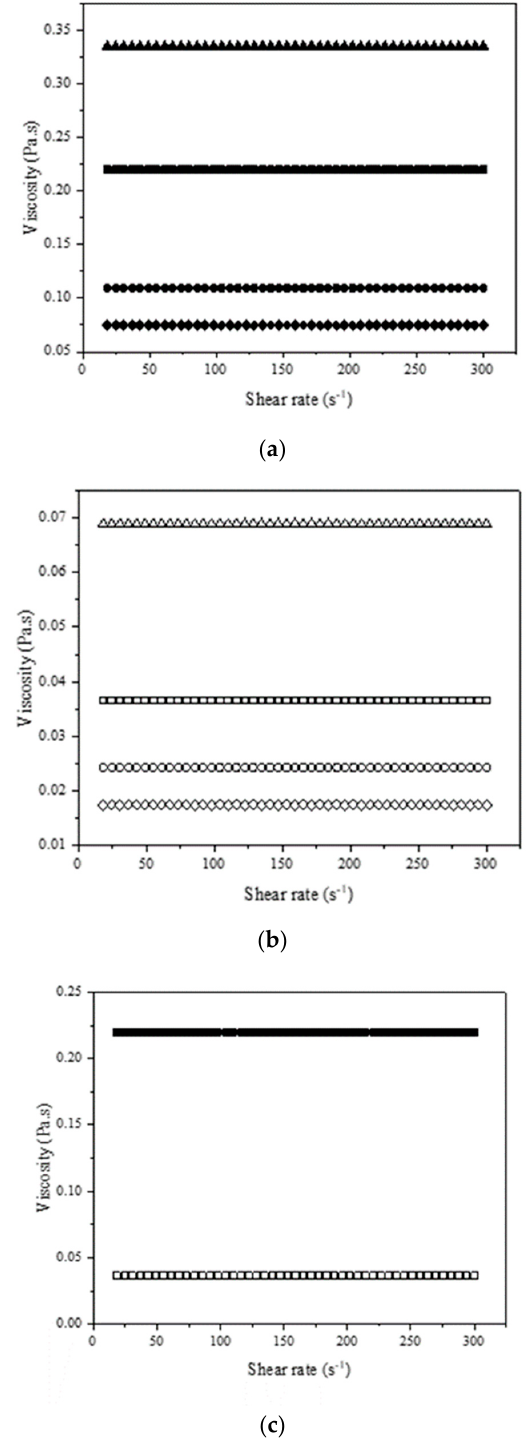
Figure 8. NADESs viscosity profile graph. ( a ) Solid symbols represent NADESs without the addition of water ( ■ lactic acid:glycine; ● lactic acid:ammonium acetate; ▲ lactic acid:sodium acetate; ♦ lac- tic acid:choline chloride); ( b ) hollowed out symbols represent NADESs with the addition of water ( (cid:3) lactic acid:glycine; lactic acid:ammonium acetate; ∆ lactic acid:sodium acetate; ♦ lactic (cid:35) acid:choline chloride). ( c ) Comparison of NADESs behavior with and without the addition of water (lactic acid:glycine (cid:4) ; (cid:3)